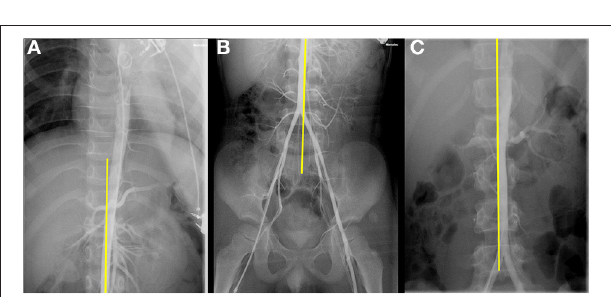
FIGURE 4 | (A,B) The aorta descended diagonally on the right side along the middle of the spine. (C) Aortogram of a boy suspected of renal artery stenosis used as a